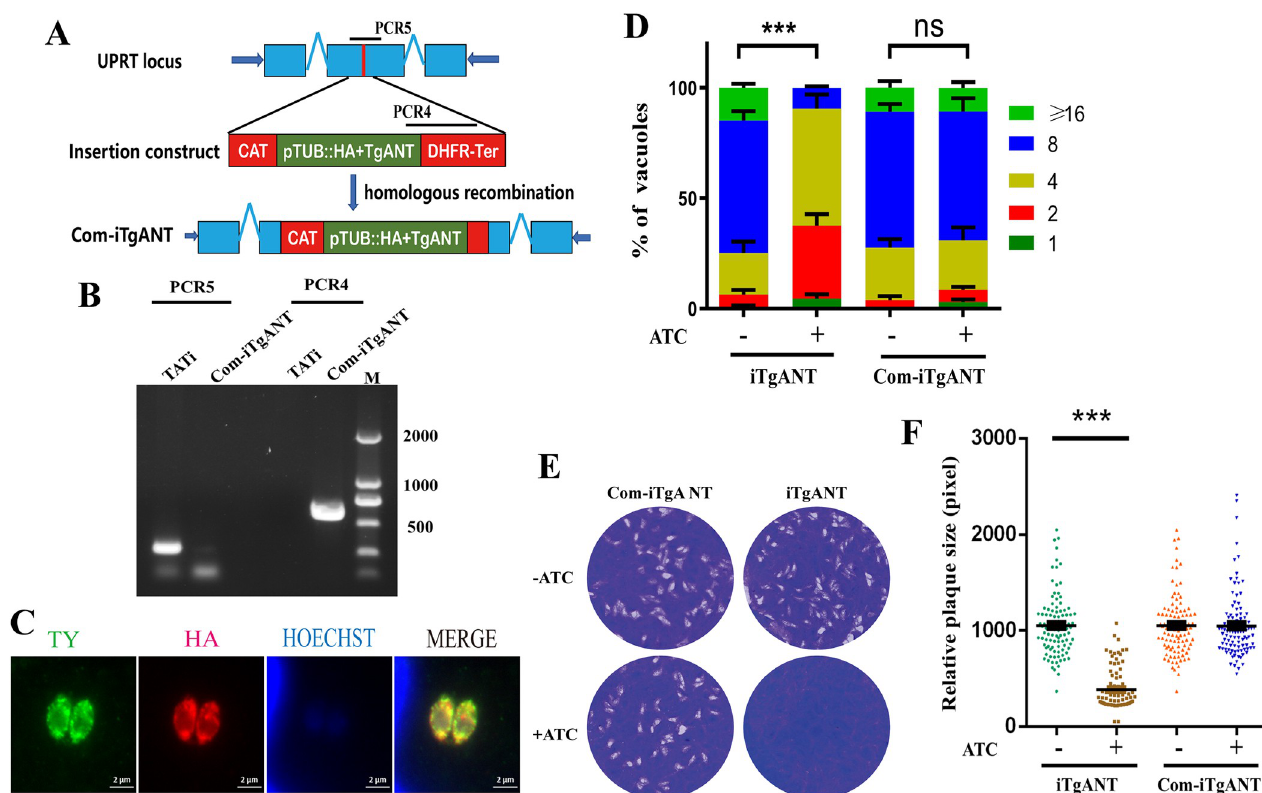
Fig 5. TgANT complementation fully restored the growth defects of TgANT depletion mutants. (A) and (B) schematic showing generation of the iTgANT strains via CRISPR-Cas9–assisted gene engineering (A) . PCR1–PCR3 indicates screening of clonal mutant (B) . (C) IFA confirmed that the ectopic TgANT (red) was successfully expressed and localized to the ER. (D) Intracellular replication assay comparing parasite proliferation under indicated conditions. TATi and Com-iTgANT strains were pretreated with 0.5 μ g/ml ATc for 40 h or left untreated. Subsequently, they were allowed to infect HFF monolayers for 40–60 min, and uninvaded parasites were washed with PBS. Whereafter, invaded parasites were cultured with 0.5 μ g/ml ATc or left untreated for 24 h to determine the number of parasites in each parasitophorous vacuole (PV). ��� p � 0.001, two-way ANOVA, three independent repeated, a representative one is shown here. (E) and (F) Plaque assays comparing the growth of TgANT depletion strain and TgANT complementation strain. Parasites were grown ± 0.5 μ g/ml ATc for 7 days to form plaques on HFF monolayers (E) . plaque size presented as relative area (pixel size calculated by Photoshop) from three independent assays (F) ��� p � 0.001, Student’s t-test, three independent